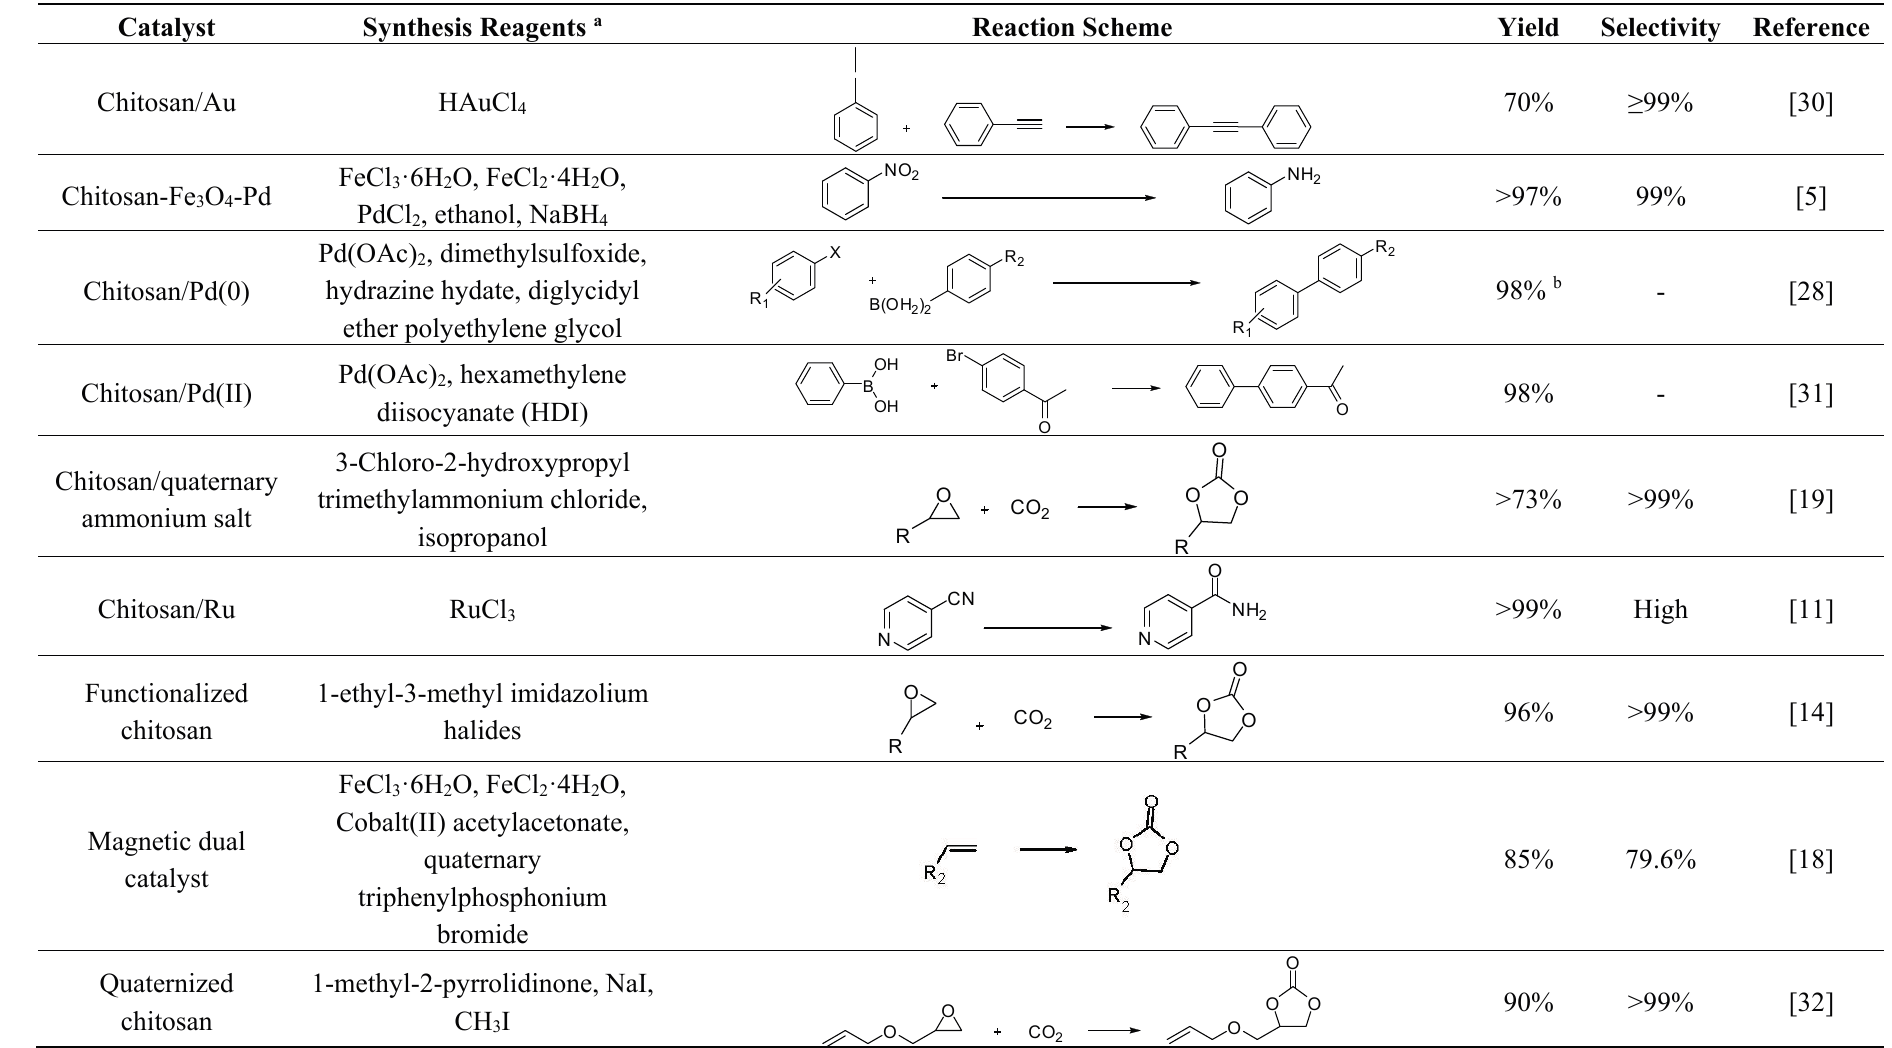
Table 1. Summary of currently reviewed chitosan-metal catalysis